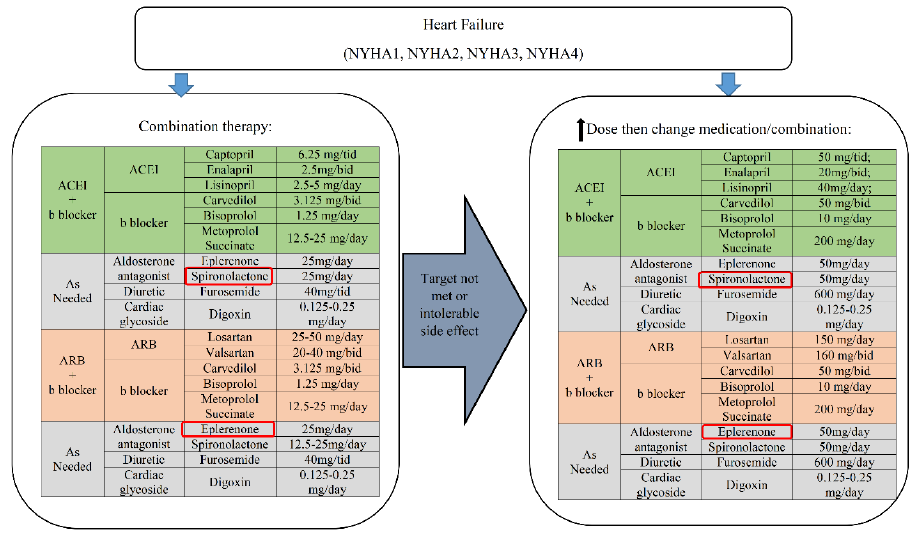
Figure A4. The di ff erent medication therapy scenarios in heart failure. Figure 2D. The different medication therapy scenarios in heart failure. Figure 2D. The different medication therapy scenarios in heart failure.